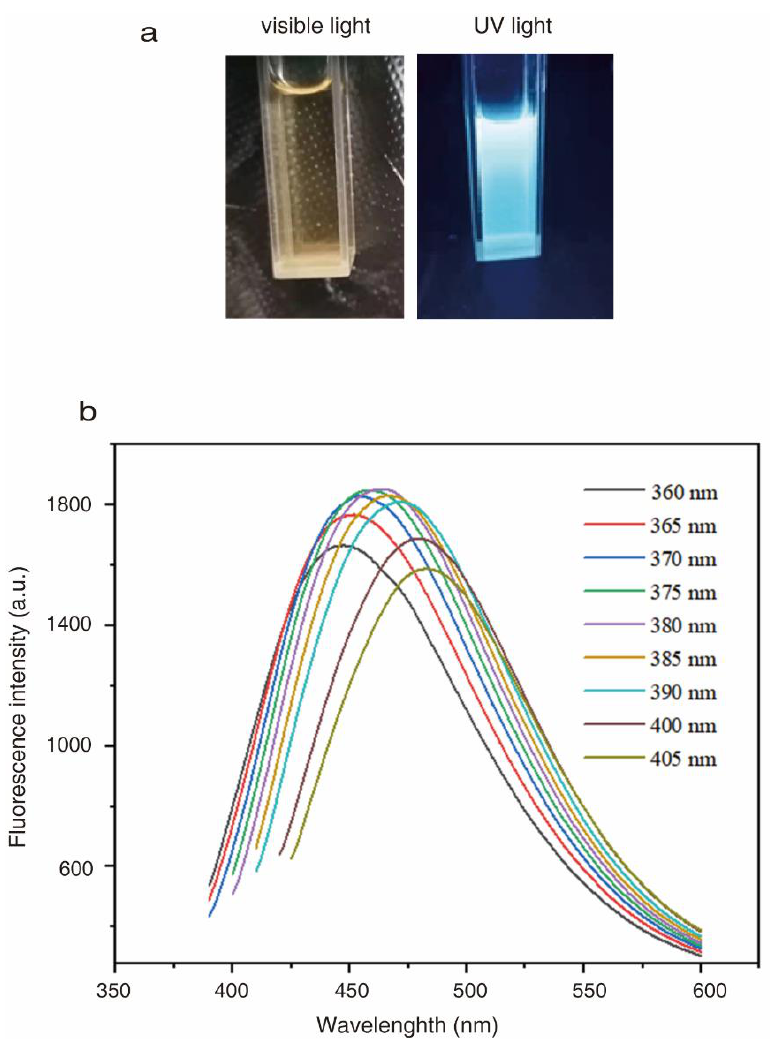
Figure 4. Optical properties of CQDs prepared from chicken bones. ( a ) Typical images of CQDs under UV and visible light irradiation are shown. ( b )Excitation-dependent fluorescence spectra of CQDs.